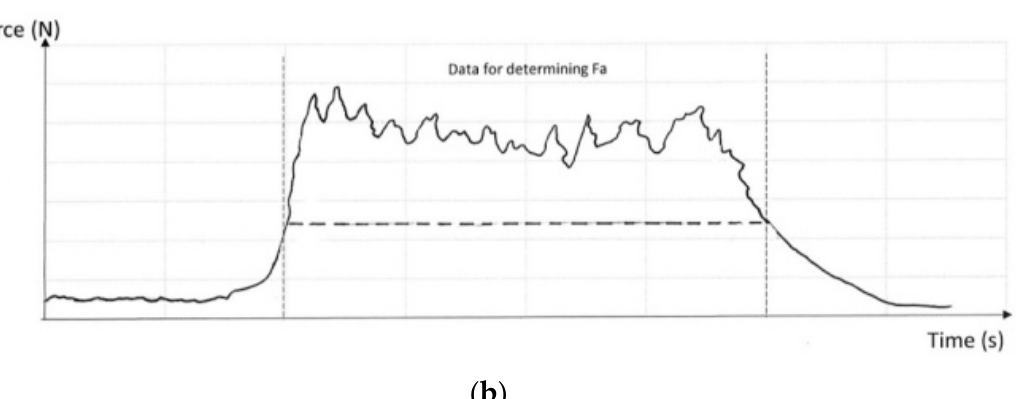
Figure 5. Criteria for calculating Fa: ( a ) Goh [15]; ( b ) ANSI/ASSP Z359.13 [17] (clause 4.1.10).